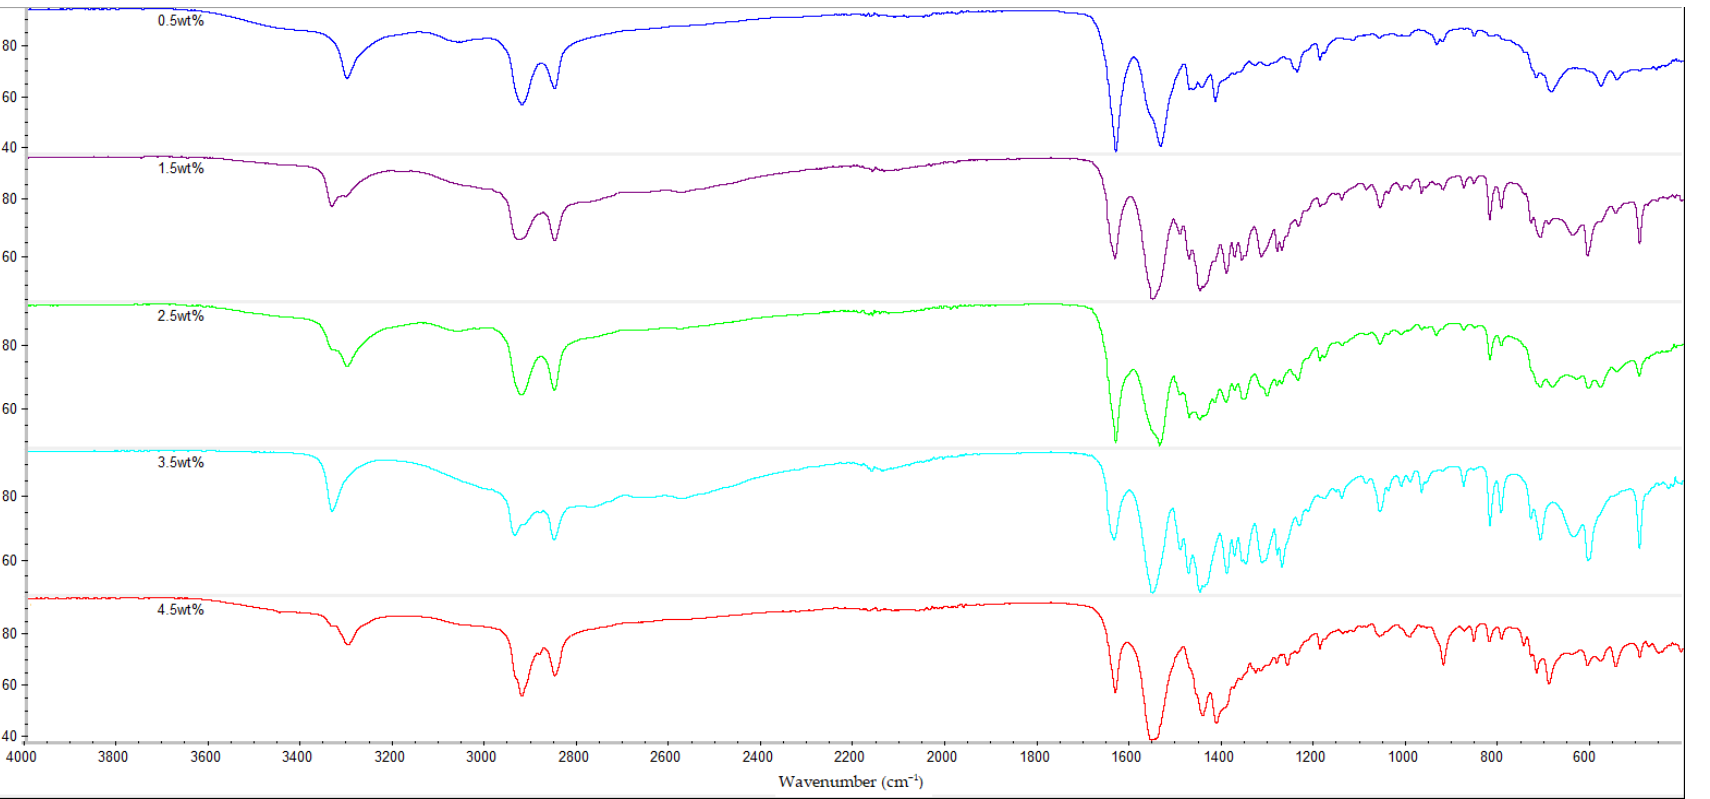
Figure 10. FTIR Spectra for Nylon 610 Nanocomposites with Treated Graphite Flakes at 200 °C and − 0.08 MPa.